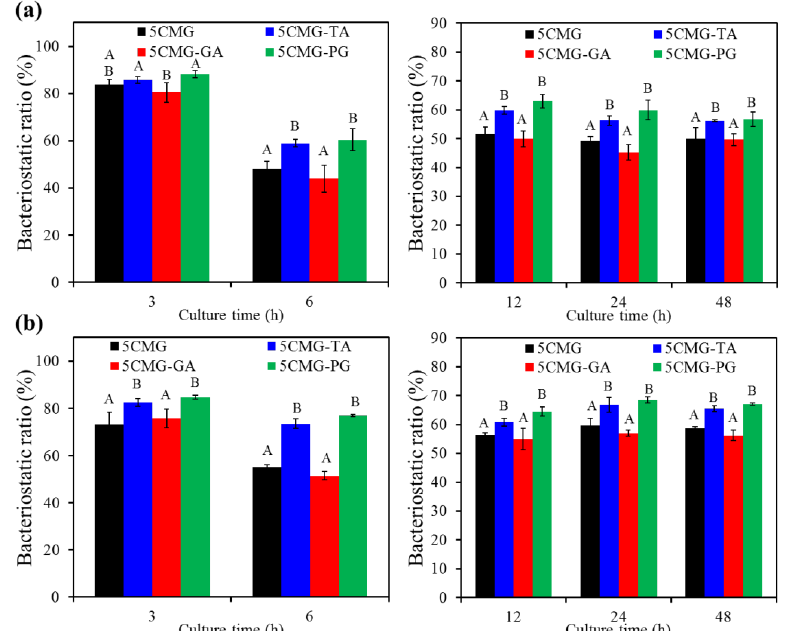
Figure 9. Bacteriostatic ratio of the various samples with and without polyphenols (TA, GA, and PG) against ( a ) E. coli and ( b ) S. aureus bacterial species after culture for short-term (3 h and 6 h) and long-term time points (12 h, 24 h and 48 h). Statistical comparisons were made between samples incubated at the same time point. Different capital letters indicated significant differences at p < 0.05.